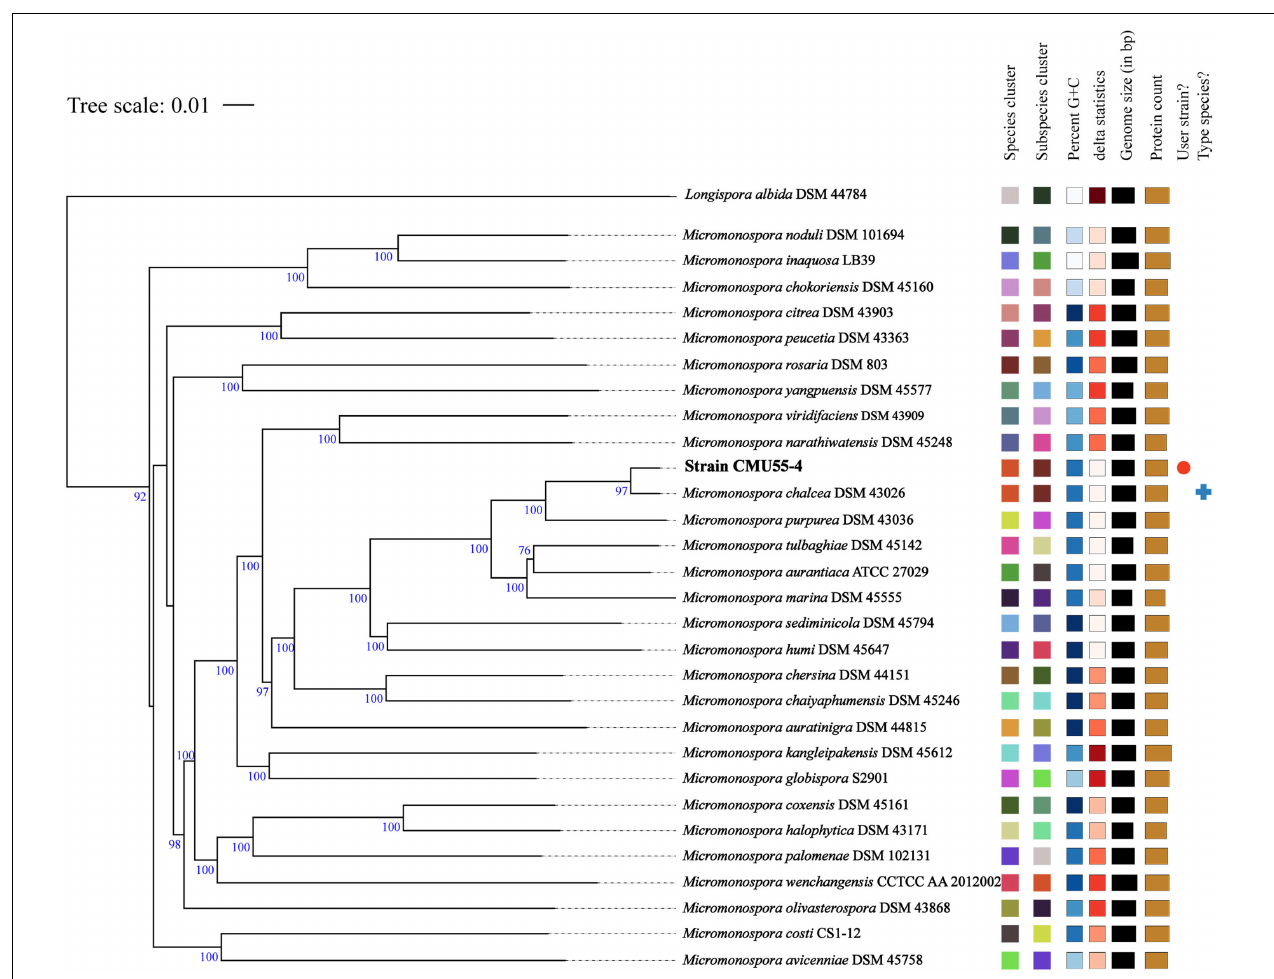
FIGURE 4 | Phylogenomic tree of strain CMU55-4 and their closely related type strains of the genus Micromonospora . Tree inferred with FastME 2.1.6.1 (Lefort et al., 2015) from Genome BLAST Distance Phylogeny (GBDP) distances calculated from genome sequences. The branch lengths are scaled in terms of GBDP distance formula d 5 . The numbers above branches are GBDP pseudo-bootstrap support values from 100 replications, with an average branch support of 92.6 %. The tree was rooted at the midpoint (Farris, 1972). Leaf labels were annotated by affiliation to species and subspecies clusters, genomic G+C content, δ values, overall genome sequence length, number of proteins, and the kind of strain,